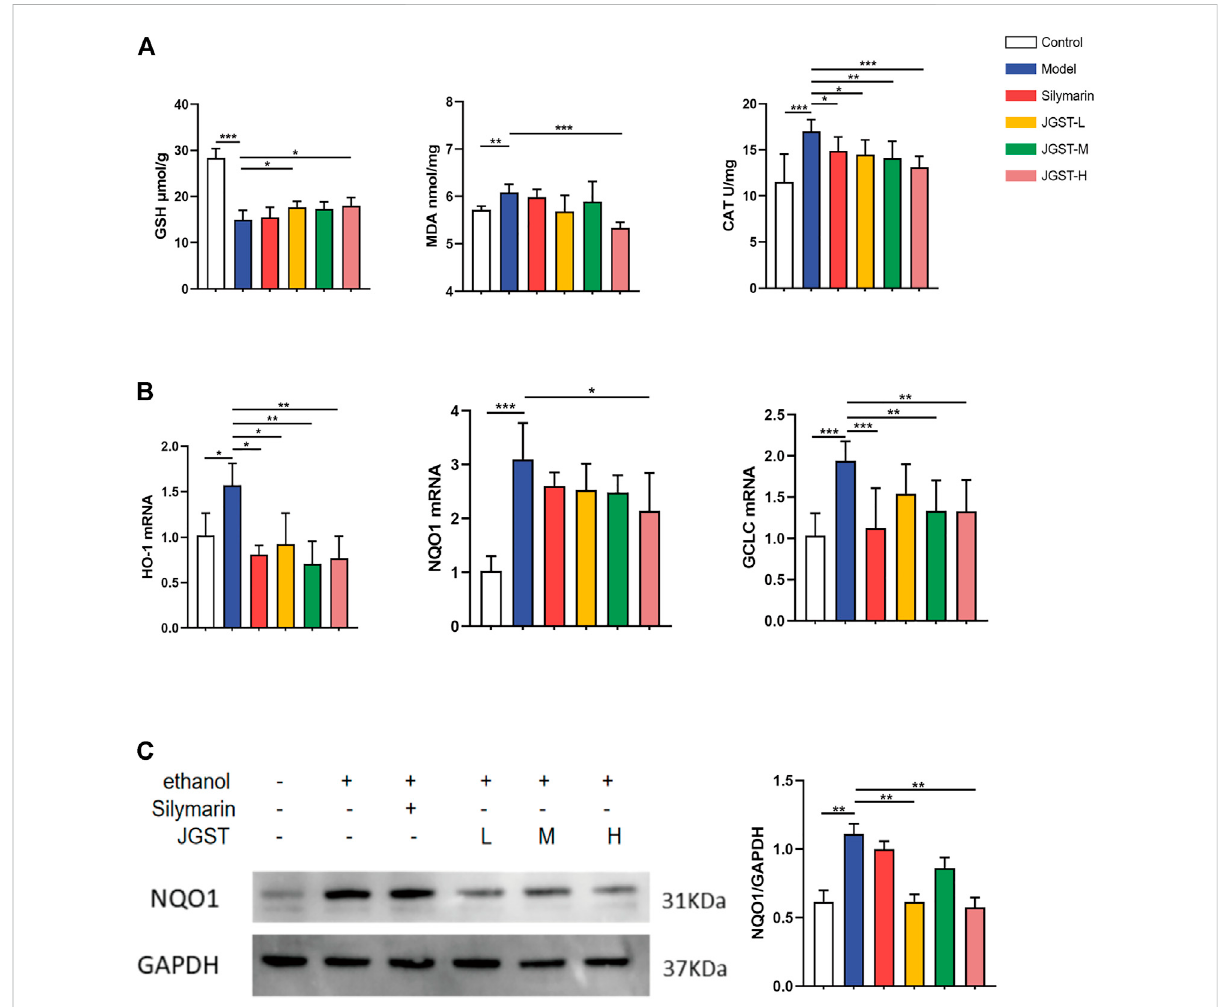
FIGURE 4 TheeffectofIGSTonoxidativestressintheAI,Dmiceliver. (A) LiverlevelofGSH,MDAandCAT. (B) mRNAexpressionofHO-1,NQO1andGCLC in liver tissues. (C) The protein expression of NQO1 in liver tissues. Data were presented as Meant ± SEM, * p < 0.05, ** p < 0.01, *** p < 0.001, n =